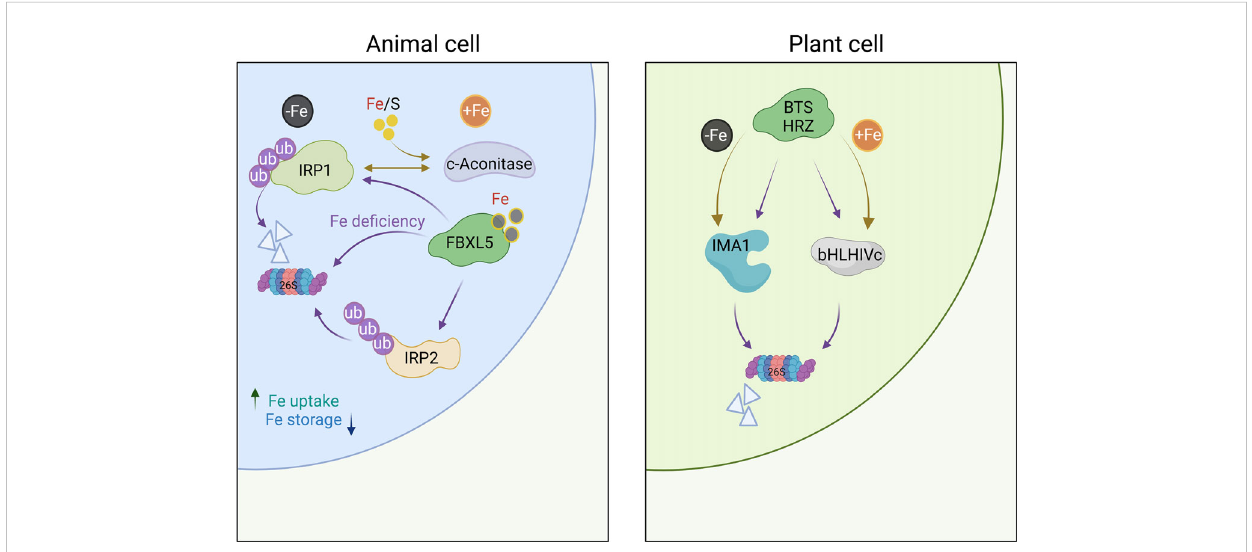
FIGURE 1 Iron sensing in mammals and plants. In mammalian cells, Fe is sensed via IRP1 and IRP2, which bind to IREs to regulate the translation of genes involved in the uptake and storage of Fe. In the presence of cytosolic Fe, IRP1 loses its sensing function and acts as an aconitase; both IRP1 and IRP2 are targeted for proteasomal degradation by FBLX5. In plants, homologs of FBLX5 (HRZ1/HRZ2) in rice and BTS/BTSL1/2 in Arabidopsis) regulate the activation of Fe-responsive genes via the abundance of clade IVc bHLH proteins, which are subjected to proteasomal degradation in the presence of Fe. Under Fe-de fi cient conditions, IMA/FEP peptides compete with clade IVc proteins for binding to HRZ/BTS, thereby revoking the inhibition of the Fe de fi ciency response by degrading IMA peptides instead of clade IVc bHLH proteins. Whether plants are able to sense Fe via a possible moonlighting function of cytosolic aconitase (ACO) enzymes has not been conclusively demonstrated for plants. Purple arrows indicate proteasomal degradation. Figure was created with